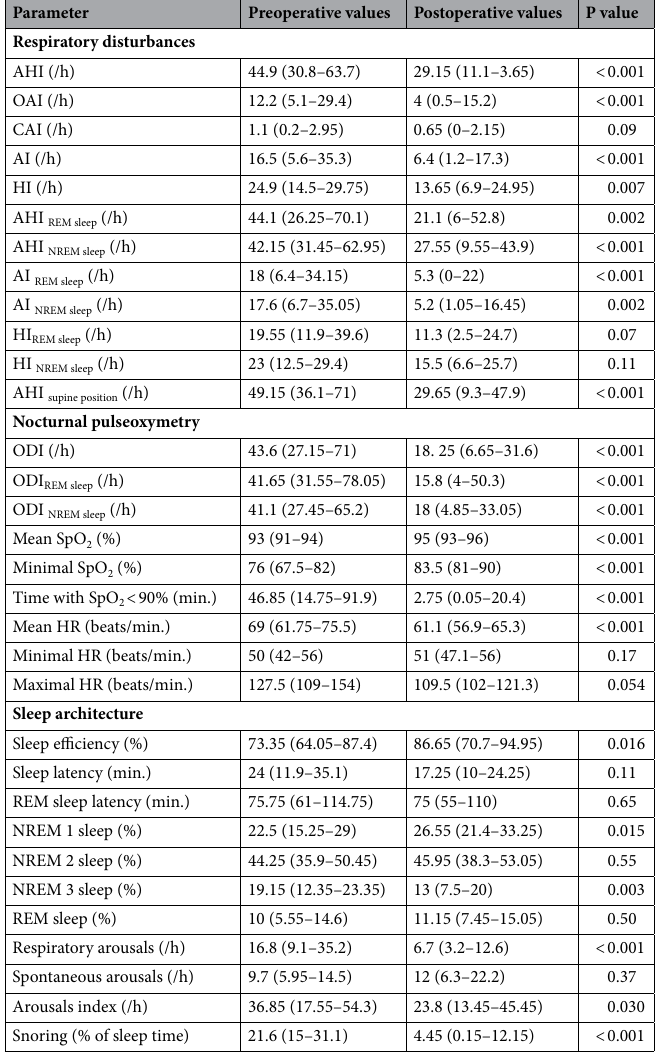
Table 2. Preoperative and postoperative PSG parameters. AI, apnea index; AHI, apnea–hypopnea index; CAI, central apnea index; HI, hypopnea index; HR, heart rate; NREM, non-rapid eye movement sleep;